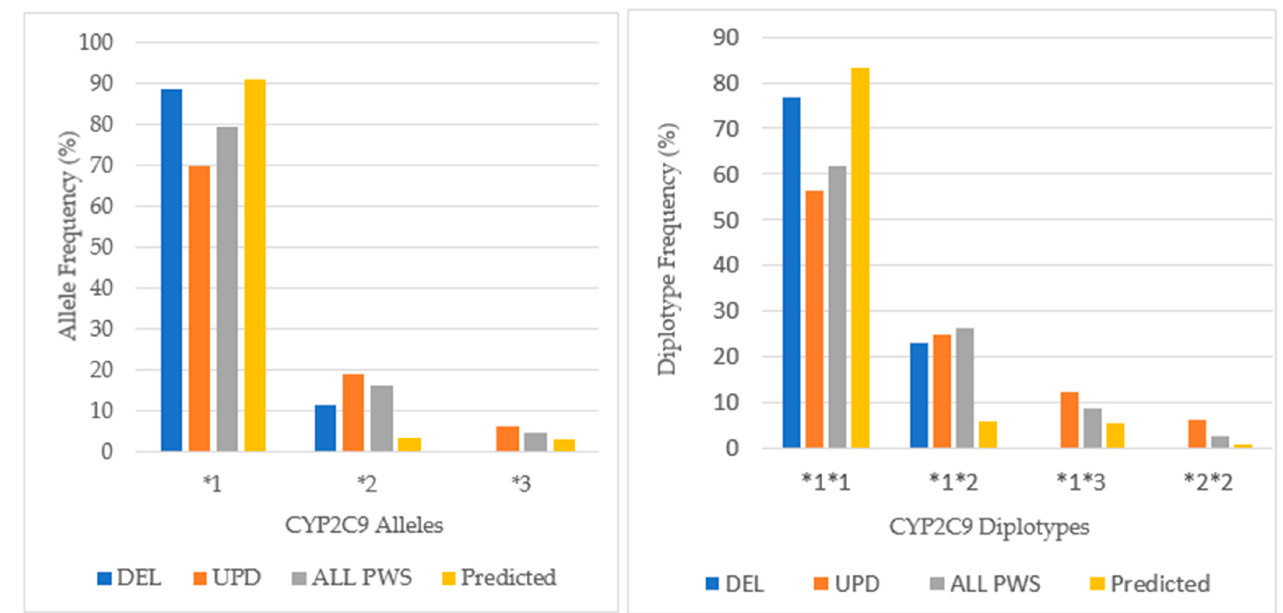
Figure 9. CYP2C9 allele and diplotype frequencies in PWS DEL ( n = 13), UPD ( n = 16) and combined cohort (ALL PWS, n = 34) compared to American normative, predicted data [http://www.pharmgkb.org/page/cyp2c9RefMaterials].